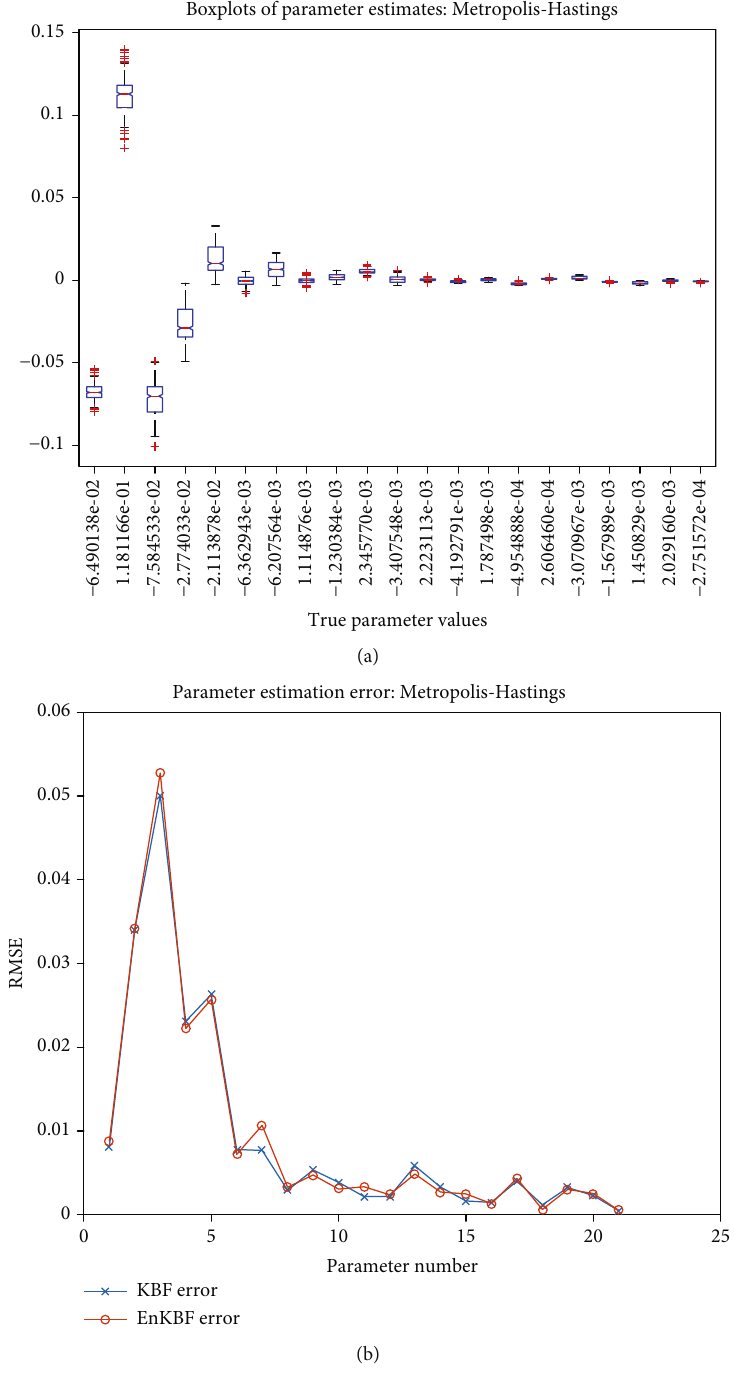
Figure 6: (a) Boxplot for velocity parameters for the EnKBF run for 1000 time steps and 1000 Metropolis-Hastings cycles. A burn-in of 500 parameter draws is discarded. The stochastic wave equation model is used with the following settings: L = 2 π , 100 grid points, δ t = 0 : 01 , M = 1000 particles, μ = 0 : 001 , and localization radius of 10 grid points. (b) A plot of the root mean square error for the parameter estimates obtained using EnKBF and KBF. The plot indicates that the performance of EnKBF matches that of KBF in this